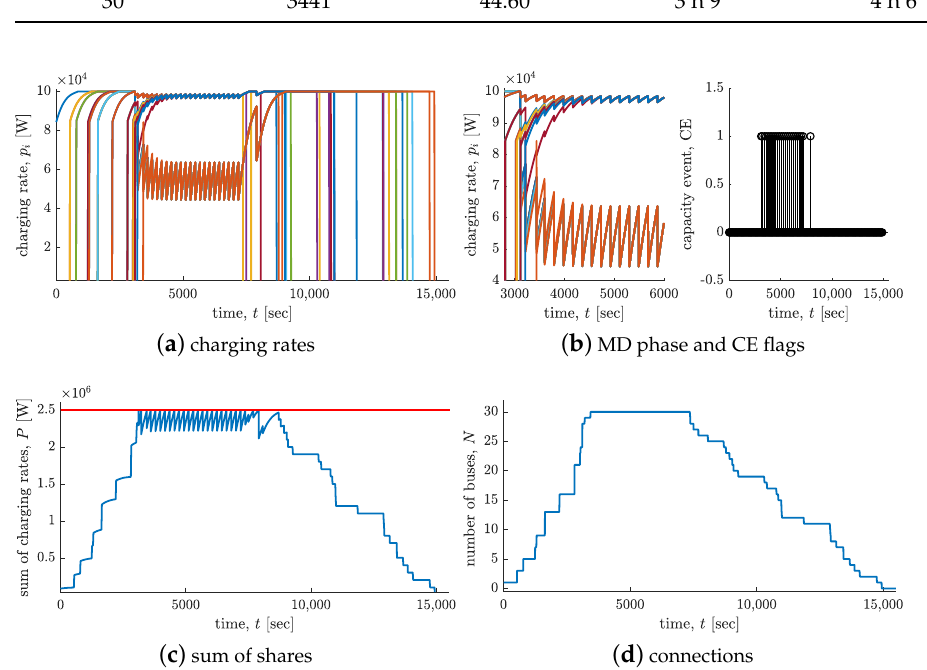
Figure 4. Simulation results when ¯ P = 2.5MW and all the batteries have saturation equal to = 100kW. ( a ) Time evolution of charging rates. ( b ) Close up of the MD phase and CEs over p i time. ( c ) Sum of shares and total capacity. ( d ) Time evolution of the number of connected buses to be